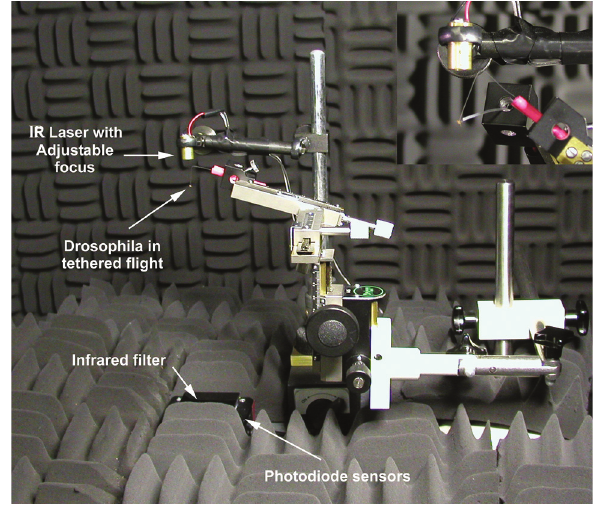
Figure 2 - Apparatus used for measurement of wingbeat frequency. A tethered fly was positioned under a solid-state infrared (IR) laser with an adjustable focus. Wingbeat shadows were cast onto IR photodiode sen- sors.Theexperimentwasrunincompletedarknessinasteelchamberwith only a single green LED (555 nm) positioned directly in the fly’s line of sight to stimulate phototaxic flight. Inset shows the laser and acoustic mi- crophone assembly (see